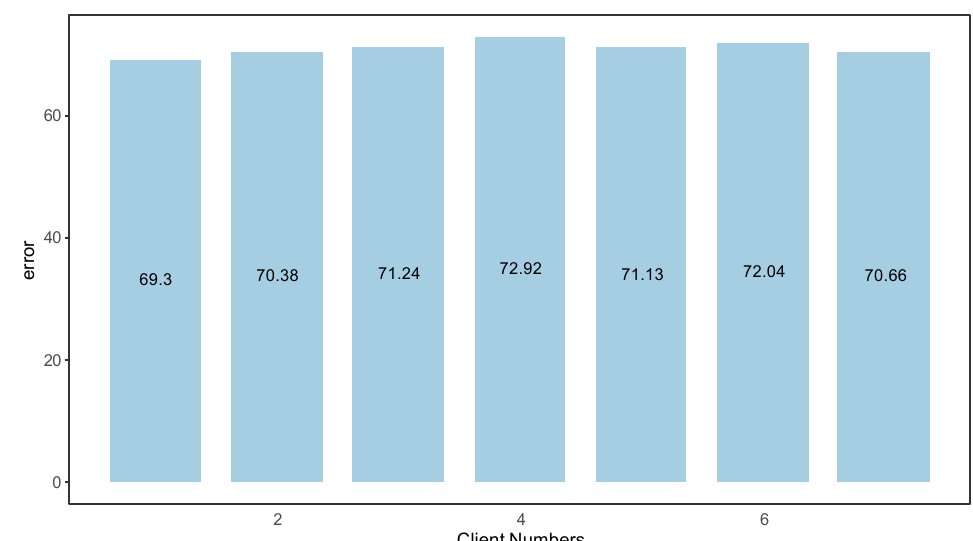
Figure 9. The sensitivity variation of our method with the same amount of data and the number of clients in different places.